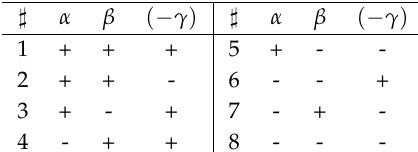
X ) = ( z ) , K Y , K Y , K Y , z 1 K X , z 2 K X , z 2 K X 1 K 2 3 3 2 1 4 4 1